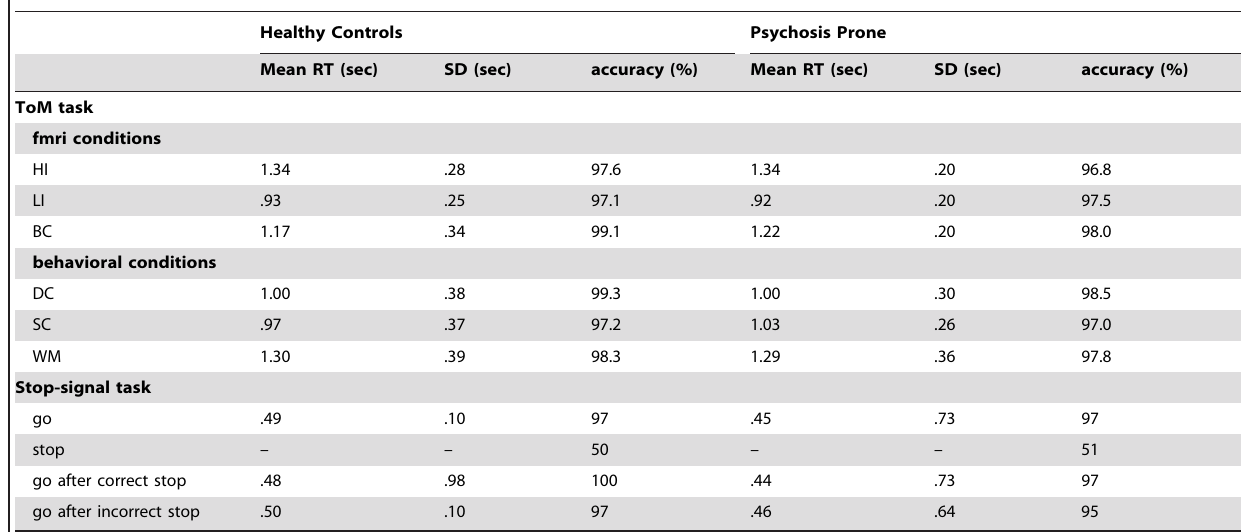
Table 2. Behavioral results ToM and stop-signal task for both